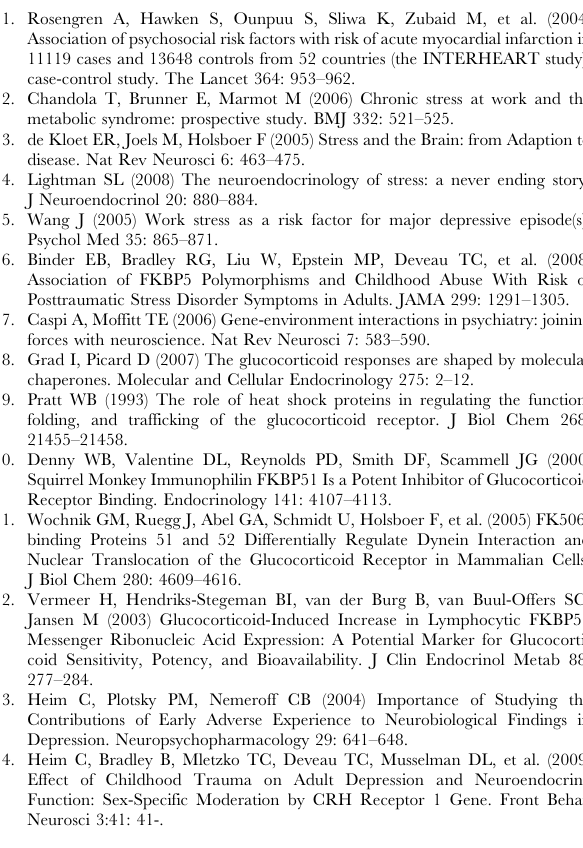
(TIF) Figure S7 Measured regions for the mapping. Coordi- nates: Interaural -0.36 mm, Bregma -4.16 mm. SC superior colliculus, DR dorsal raphe nucleus, VTN ventral tegmental nucleus. (TIF) Figure S8 Measured regions for the mapping. Coordi- nates: Interaural -1.54 mm, Bregma -5.34 mm. LC locus coeruleus, TMN trigeminal motor nucleus, IC inferior colliculus. (TIF) Figure S9 Measured regions for the mapping. Coordi- nates: Interaural -2.44 mm, Bregma -6.24 mm. FN facial nucleus. (TIF) Figure S10 Identification of the cortex layers. Coordi- nates: Interaural 0.26 mm, Bregma 4.06 mm. Only the cortex is shown. I Layer 1, II Layer 2, III Layer 3, IV Layer 4, V Layer 5, VI Layer 6.